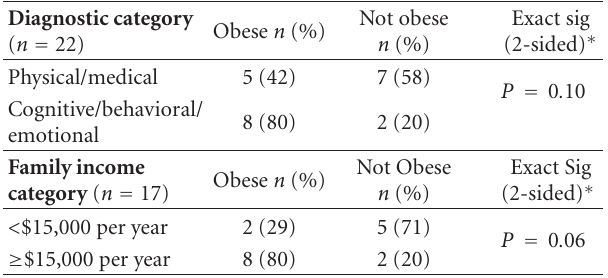
Table 7: Chi-square